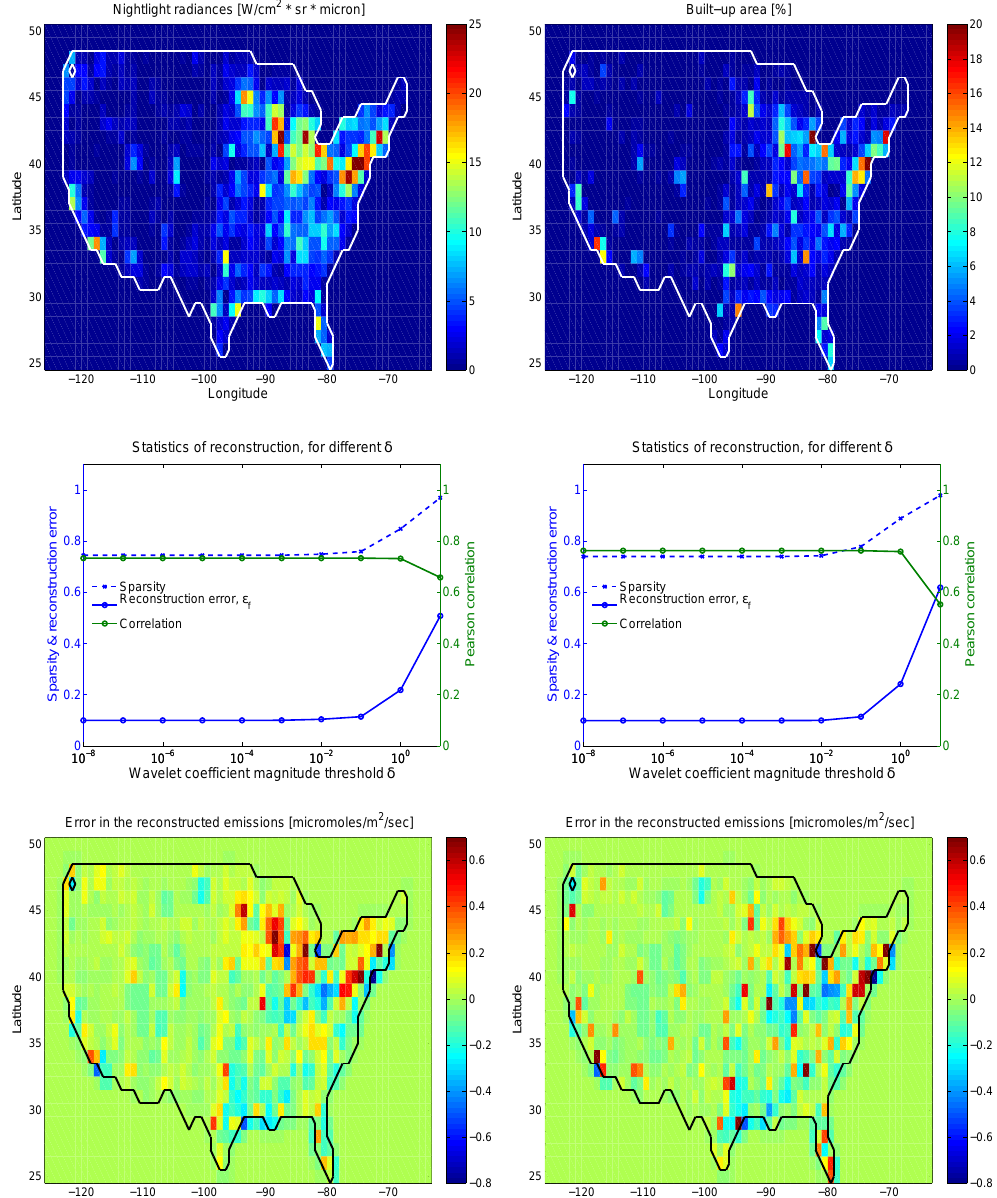
Figure 6. Top row: maps of nightlight radiances (left) and BUA percentage (right), for the US. Middle row: the sparsity of representation, the correlation between X and f V and the normalized error (cid:15) f between the Vulcan emissions f V and the sparsified form obtained by projecting it on X . These values are plotted for nightlights (left) and the BUA maps (right). Bottom row: plots of ( f pr − f V ) obtained from nightlights (left) and BUA maps (right).